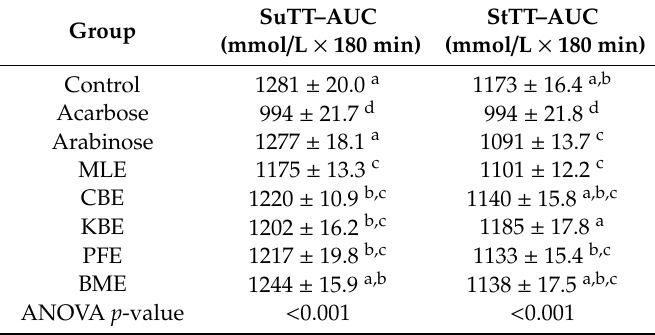
ANOVA p -value < 0.001 <